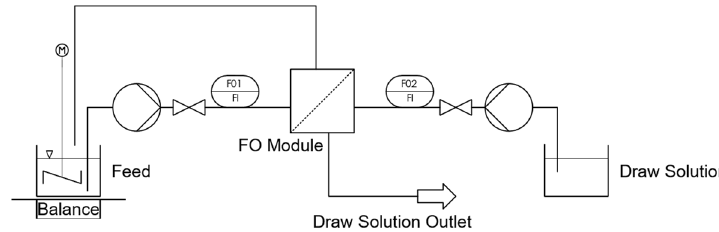
Figure 4. Experimental